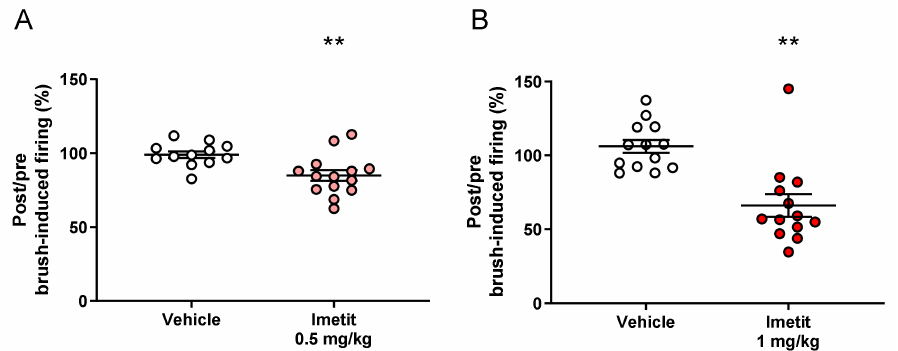
Figure 1. Imetit suppresses penile mechanical stimuli-evoked firing of the peripheral nerve: ( A ) 0.5 mg/kg and ( B ) 1.0 mg/kg. The genital area was first stimulated with a brush, following which evoked firing was evaluated. The post and pre-administration ratios are displayed. Data are presented as the mean ± S.E.M. ** p < 0.01 vs. vehicle group analyzed using Student’s t -test (n =